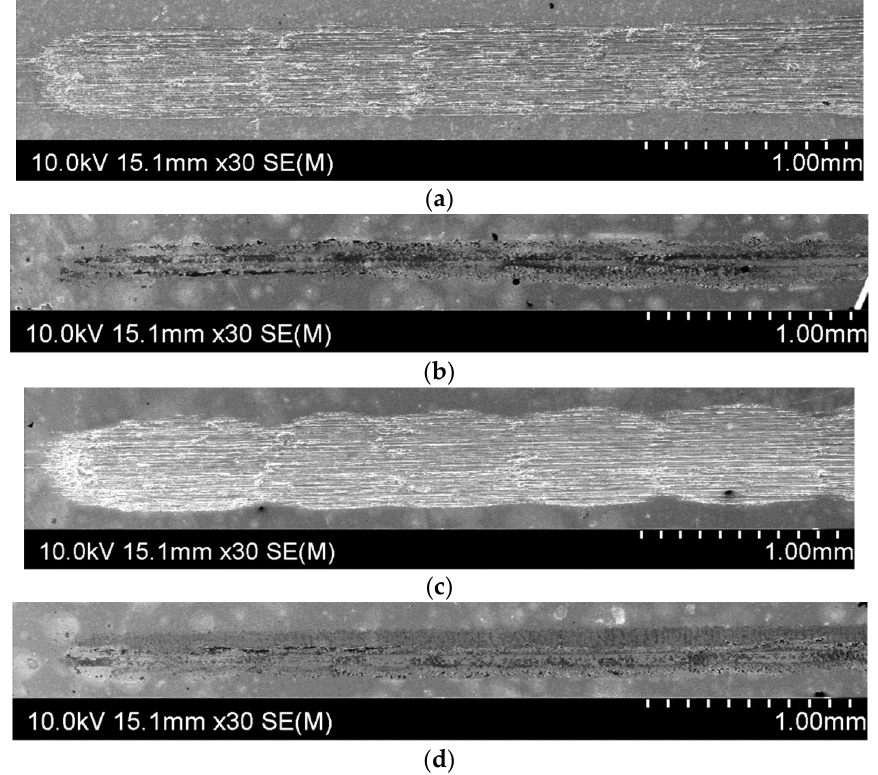
Figure 4. SEM images of SLM-N1 sample wear tracks after ( a ) first, ( b ) second, ( c ) third, and ( d ) fourth experiments.